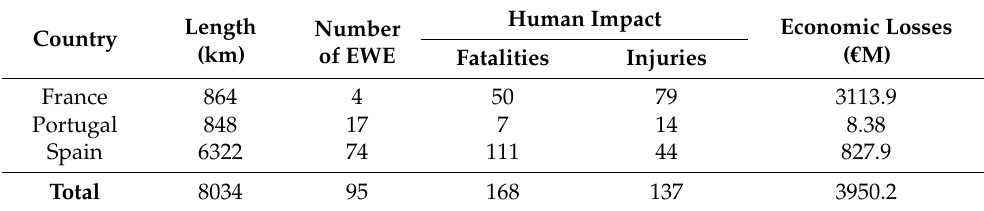
Table 1. Summary by country of the number of extreme weather events recorded, fatalities, injuries and economic damage caused during the period analysed.